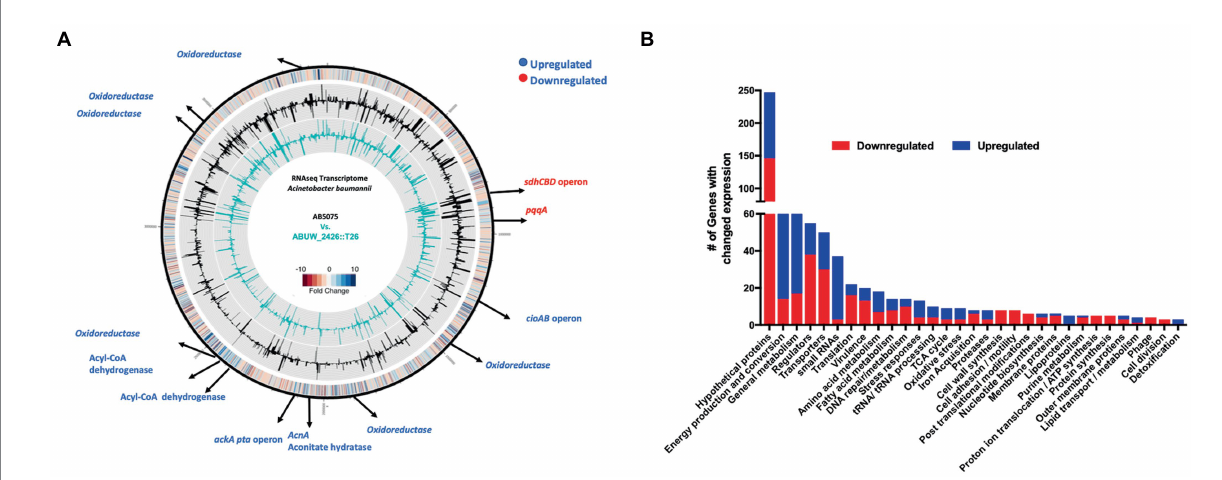
FIGURE 4 Transcriptomic profiling of the amsR mutant. (A) Genomic map showing major transcriptional changes in the amsR mutant compared to the wild-type after 2 h exposure to CCCP. The outermost circle represents a heat map of changes in amsR − compared to AB5075. The middle circle (black) depicts RPKM values for AB5075. The inner circle (turquoise) depicts RPKM values for the amsR mutant. Black arrows at specific locations highlight genes that function in energy conversion and production. Genes in blue are upregulated and in red are downregulated in amsR − . (B) Categorization of genes differentially expressed in amsR − compared to the wild-type based on